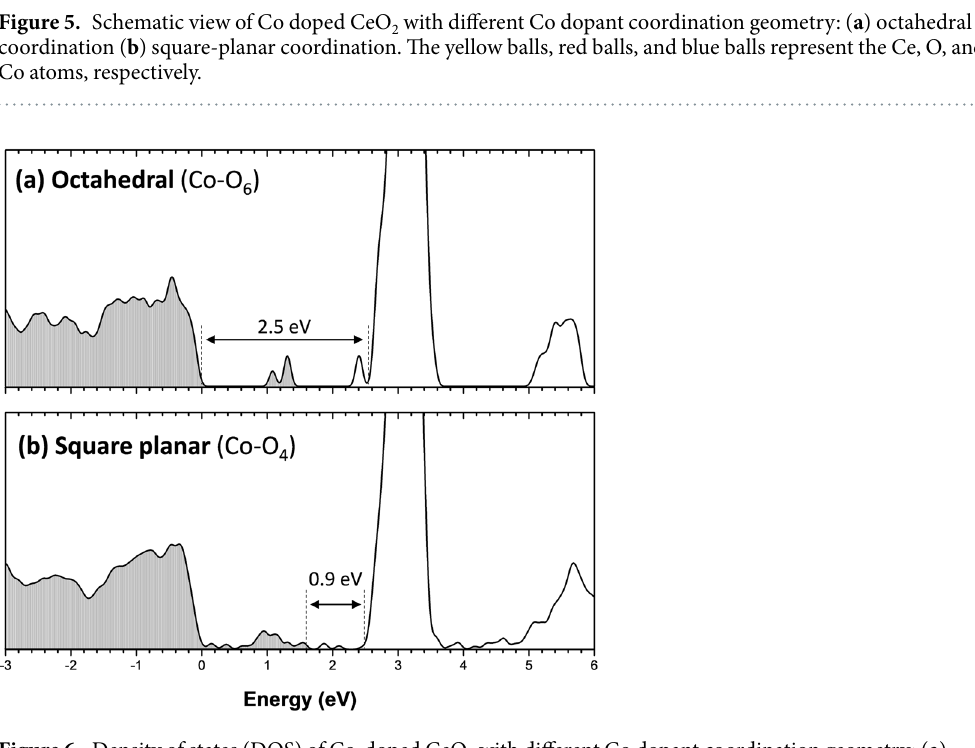
Figure 6. Density of states (DOS) of Co-doped CeO 2 with different Co dopant coordination geometry: ( a ) octahedral coordination ( b ) square planar